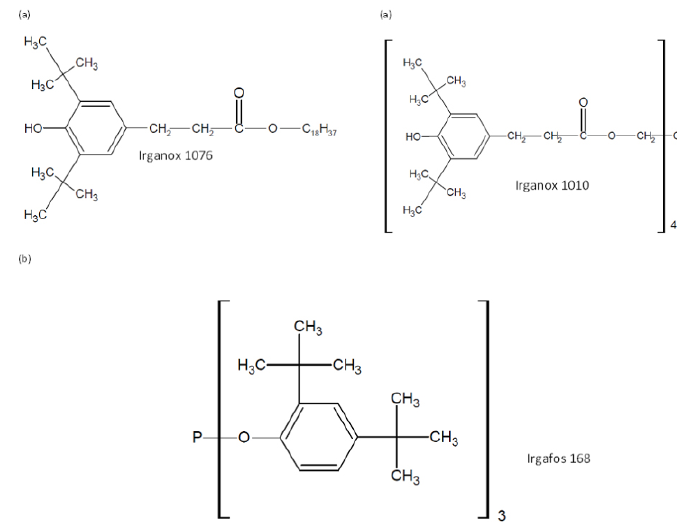
Figure 1. Structures of major polyolefin antioxidants (a) high mass phenolic antioxidants; (b) phosphite